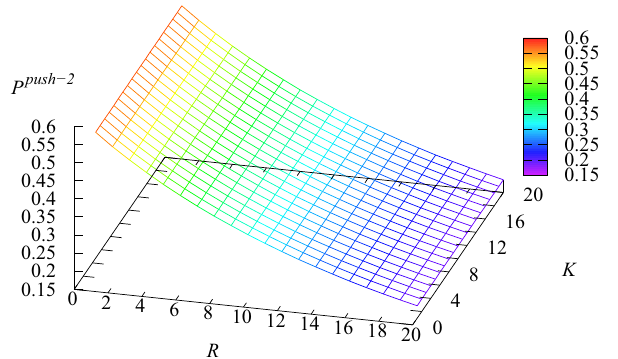
Figure 21. Dependence of the probability P push − 2 that an arbitrary Type-2 request upon arrival will push the first request from the intermediate buffer to the main buffer on K and R